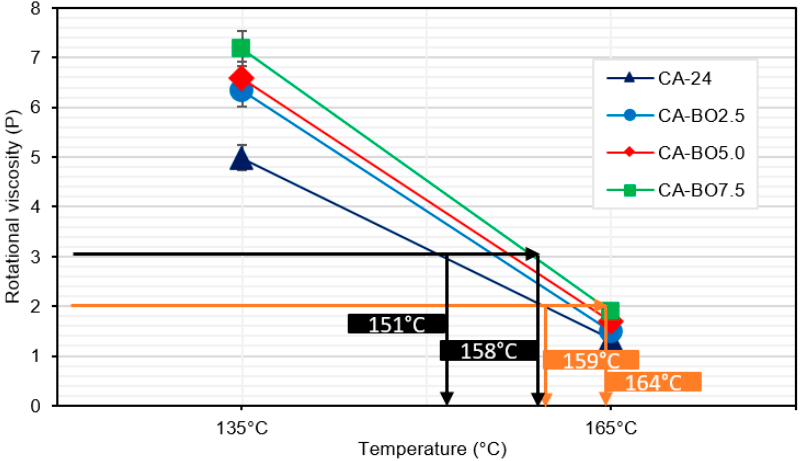
Figure 8. In black, mixing temperature (2 P) and in orange, compaction temperature (3 P) of the asphalt binder samples